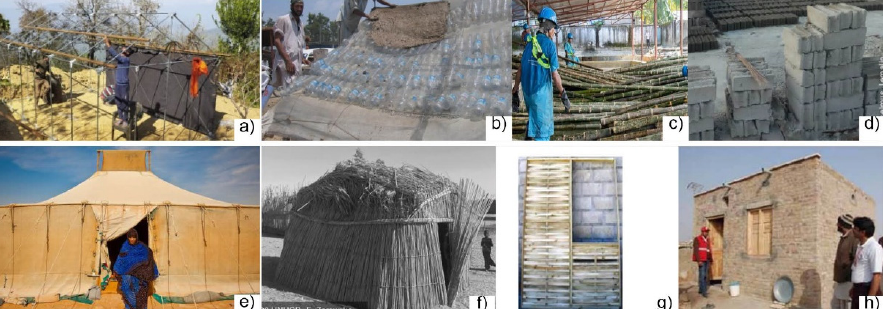
Figure 7. Selected transitional shelters. ( a ) RHU, UNHCR and Better Shelter (© Better Shelter)[55,56]; ( b ) Emergency prolongation in Pakistan, Shah et al., 2020 [57]; ( c ) Rohingya crisis, Shelter Cluster, Bangladesh, 2017 (© Nate Webb) [39]; ( d ) Indonesia earthquake, Shelter Cluster 2018–2020 (@An ‐ selmus Jemalin) [39]; ( e ) Sahrawi refugees’ camp, Tuaregs and Shelter Cluster [55]; ( f ) Emergency prolongation in Chad, Shelter Cluster, 2022 (©2022 UNHCR ‐ E.Zorawska) [39,50]; ( g ) T ‐ Shelter, IFRC, Haiti, 2010 [46,58]; ( h ) One Room Shelter, UNHCR, Pakistan, 2010 [46,59].